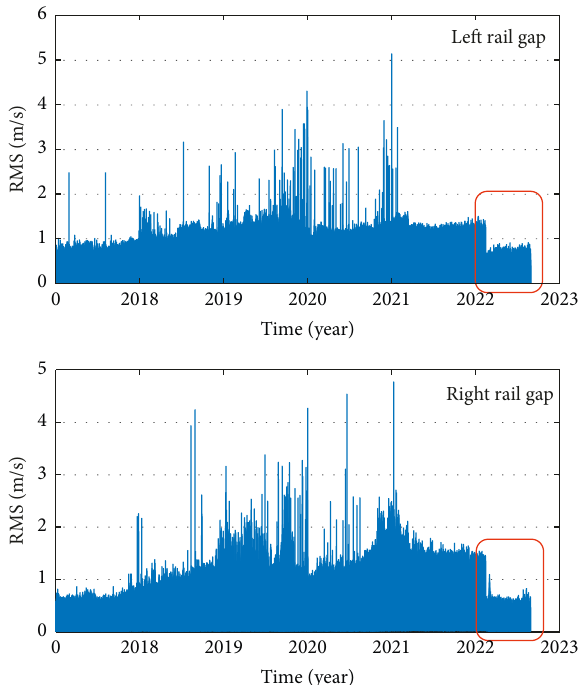
Figure 2: Vertical acceleration effective value of girder hinge region.